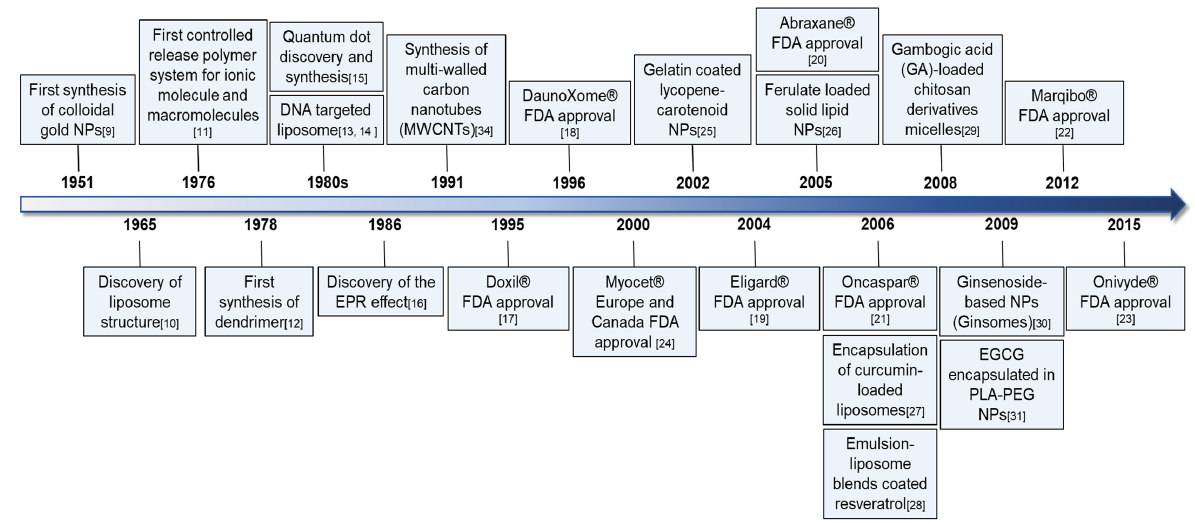
Figure 1. Research milestones of nanotechnology, anticancer nanodrugs, and nano-phytochemicals.